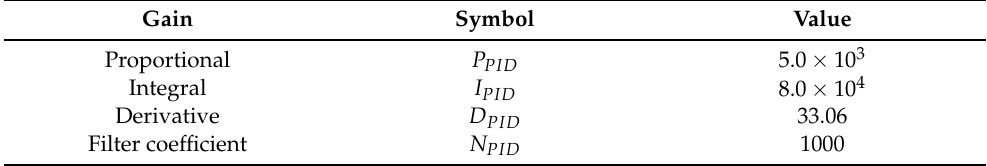
Table 3. Position controller